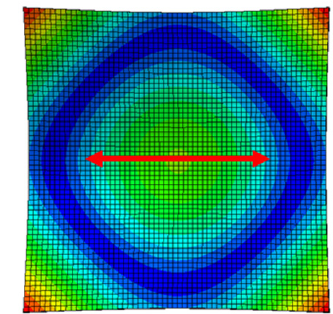
Figure 11. Second natural frequency of the FC plate using the NLR method. ( a ) Accelerometer and ( b ) PVDF sensor. In the second mode, the vibration bends the plate area inside the blue “circle” in Figure 12, which corresponds to the fiber cutting location. This could create the nonlinearities in the vibration of the plate observed in Figure 11.